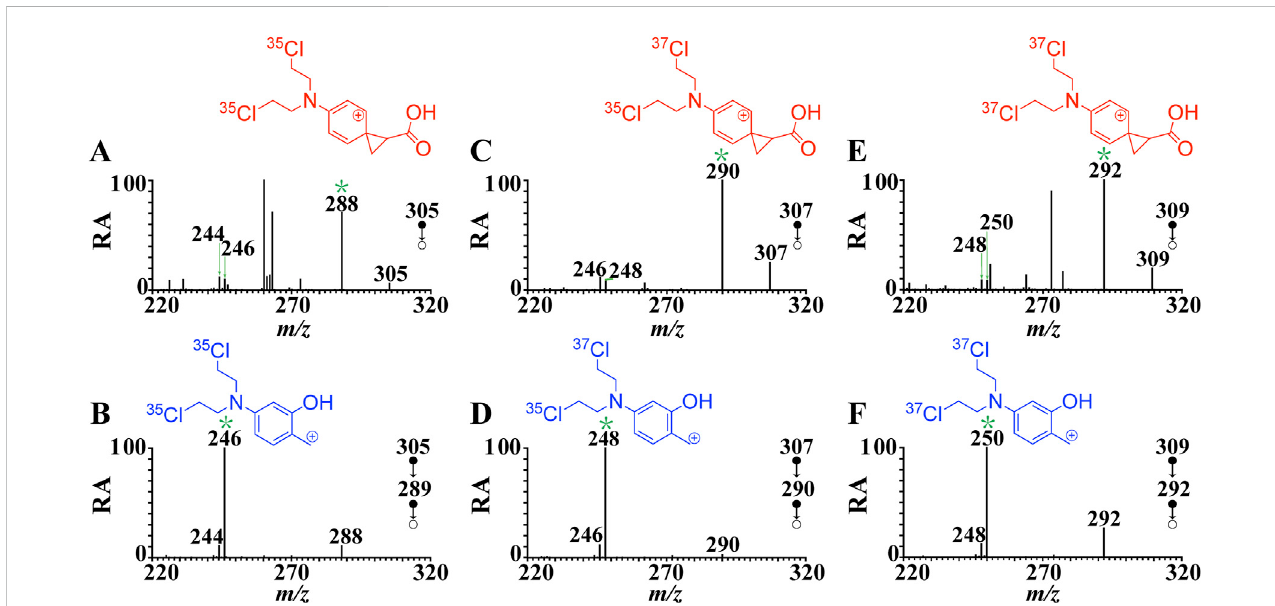
FIGURE 1 CID mass spectra of [melphalan + H] + at the normalized collision energy of 20% (A) MS 2 spectrum of [melphalan - 35 Cl 35 Cl + H ] + ( m/z 305 → ), (B) MS 3 spectrum of [melphalan - 35 Cl 35 Cl + H] + ( m/z 305 → m/z 288 → ), (C) MS 2 spectrum of [melphalan - 37 Cl 35 Cl + H] + ( m/z 307 → ), (D) MS 3 spectrum of